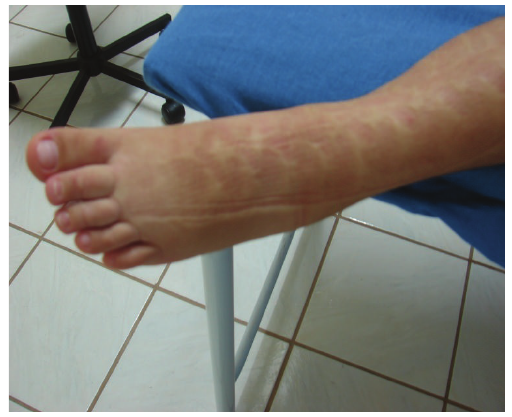
Figure 2: Normalization of the edema using an association of a grosgrain compression stocking and cervical